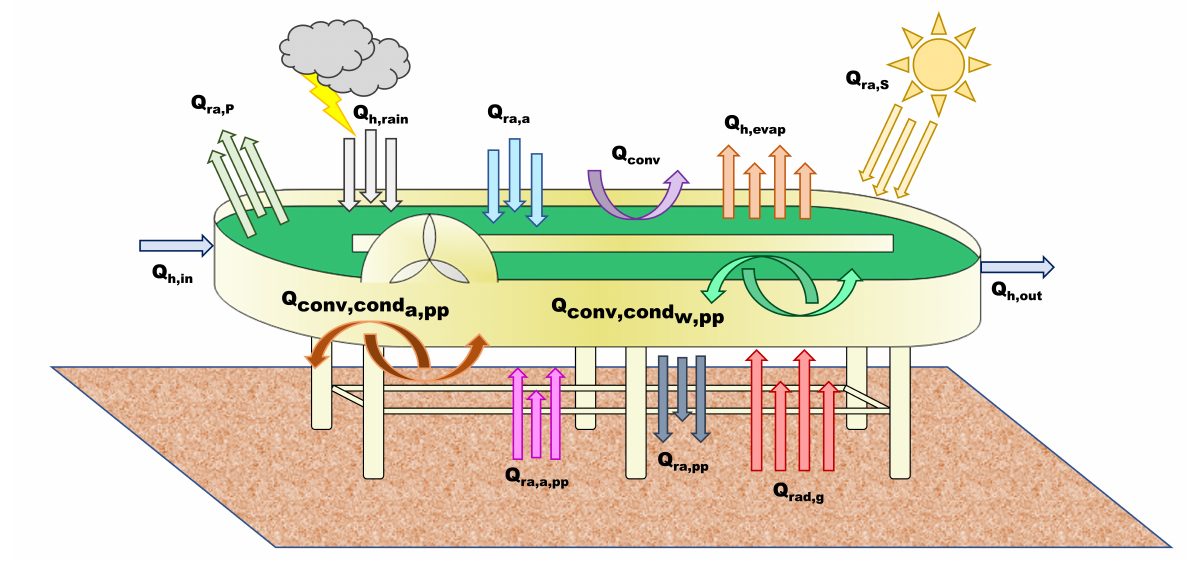
Figure 2. Heat fluxes considered in the radiative transfer